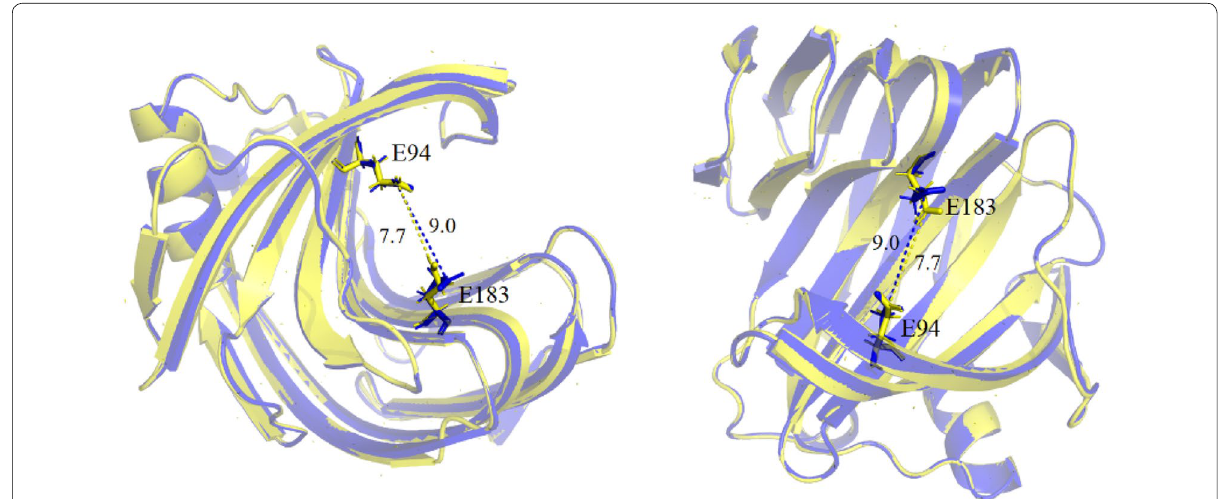
Fig. 3 Homology modeling and structure comparison between XynHBN188A (yellow) and XynHBN188A217